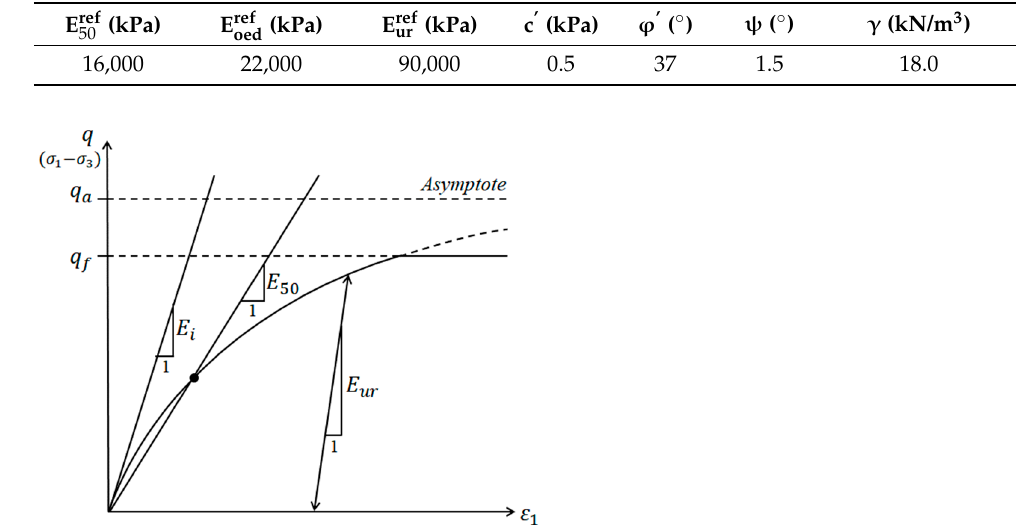
Table 1. Soil parameters of the hardening soil model in the numerical analysis [30].